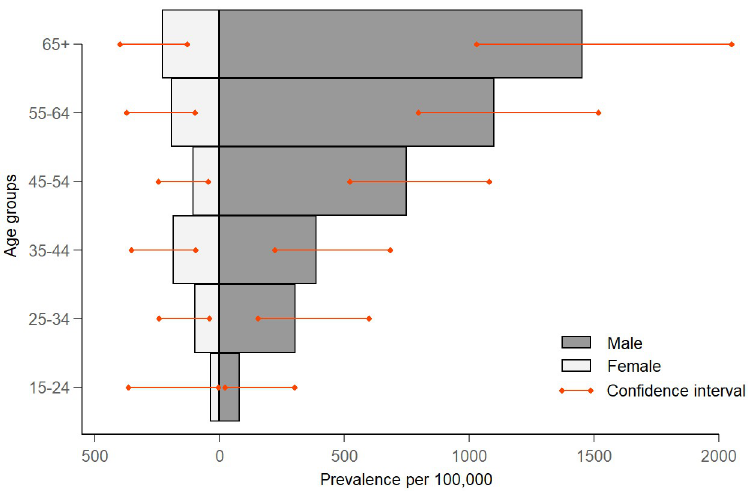
Fig 3. Comparison of the prevalence of bacteriologically confirmed tuberculosis per 100,000 population between males and females by age group.